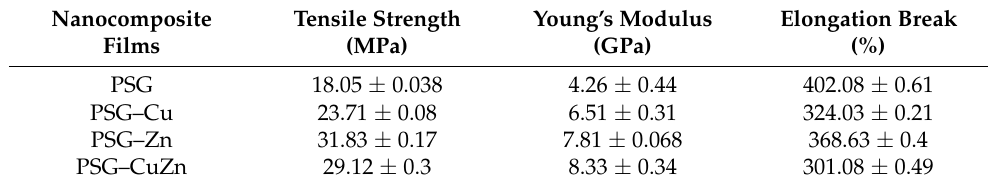
Table 1. Mechanical properties of the polymer composite films analyzed following the